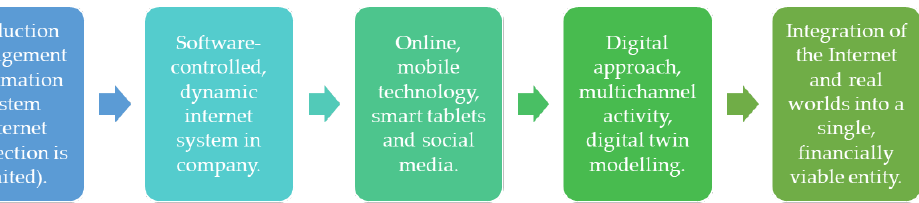
Figure 1. Five phases of digital transformation for businesses. Source: Authors ’ compilation.